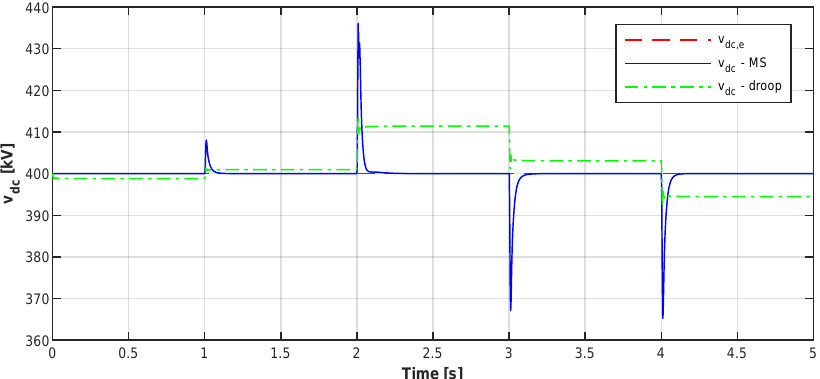
Figure 12. DC voltage measured at the master